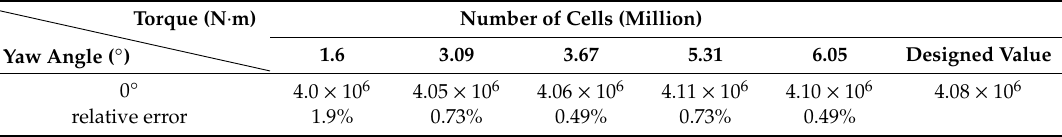
Table 2. Computed torque of di ff erent grid size averaged in one revolution.